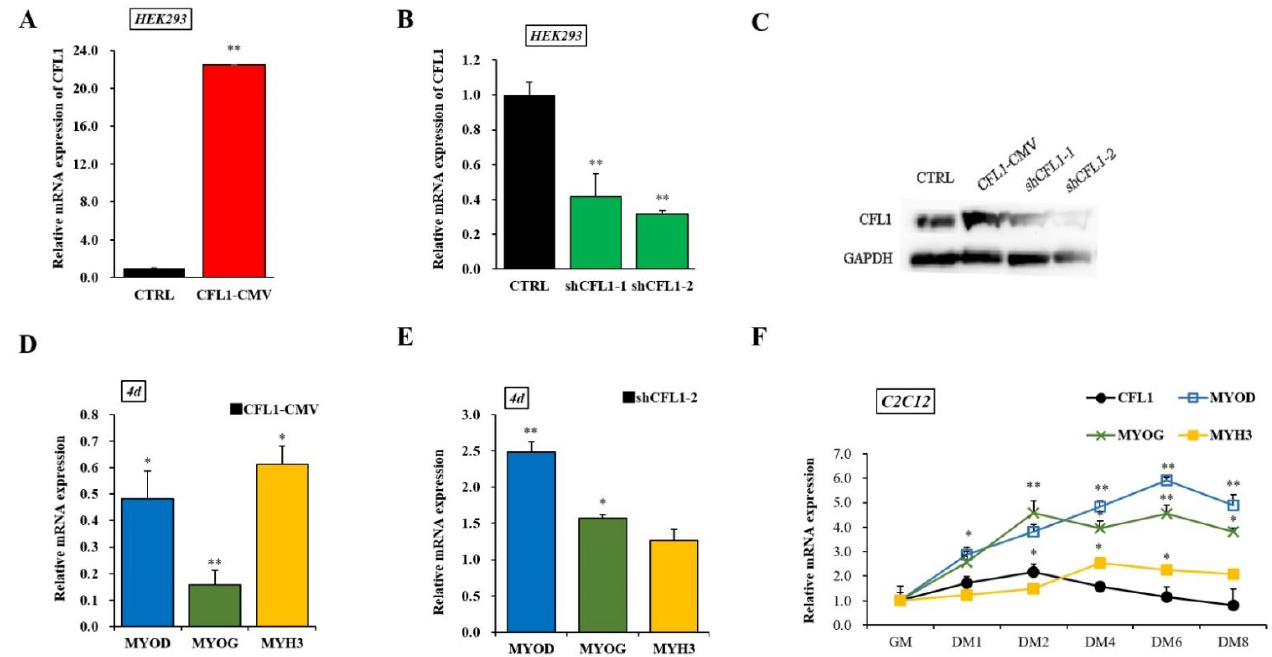
Figure 4. Construction of adenovirus overexpression and interference vectors of the CFL1 gene. Expression efficiency of CFL1 was detected by qRT-PCR ( A , B ) and western blot ( C ) in HEK293 cells after being transfected with adenovirus overexpression (CFL1-CMV) and interference (shCFL1-1 and shCFL1-2) vectors for 48 h. The C2C12 cells were induced to differentiate for 4 days after being transfected with CFL1-CMV or shCFL1-2, and the relative expression of myoblast differentiation marker genes MYOD , MYOG , and MYH3 were detected by qRT-PCR ( D , E ). Expression trends of the CFL1 gene and myogenesis factors were detected in C2C12 cells after differentiation had been induced for 1, 2, 4, 6 and 8 days by 2% horse serum ( F ). The mRNA expression level was normalized to GAPDH . Data are means ± SE of n = 3 independent experiments, each performed in triplicate. *, p < 0.05 and **, p < 0.01, two-tailed t test. CTRL, Control. GM, growth medium. DM, differentiation medium.